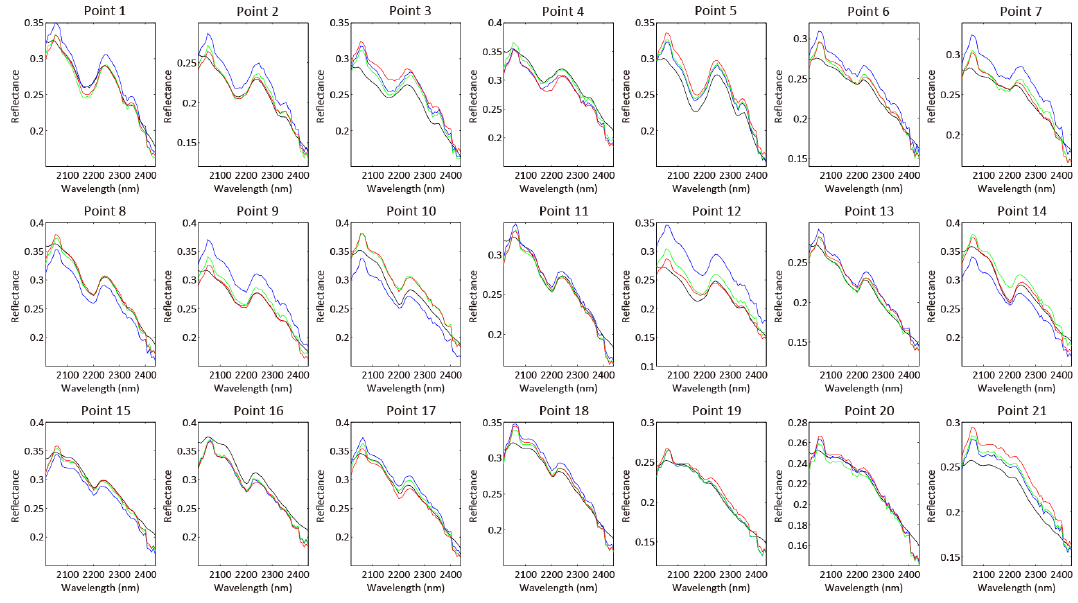
Figure 5. Comparison of spectral signatures between ( black ) reference; ( blue ) bicubic interpolation; ( green ) GSA; and ( red ) CNMF images at 21 points [37].